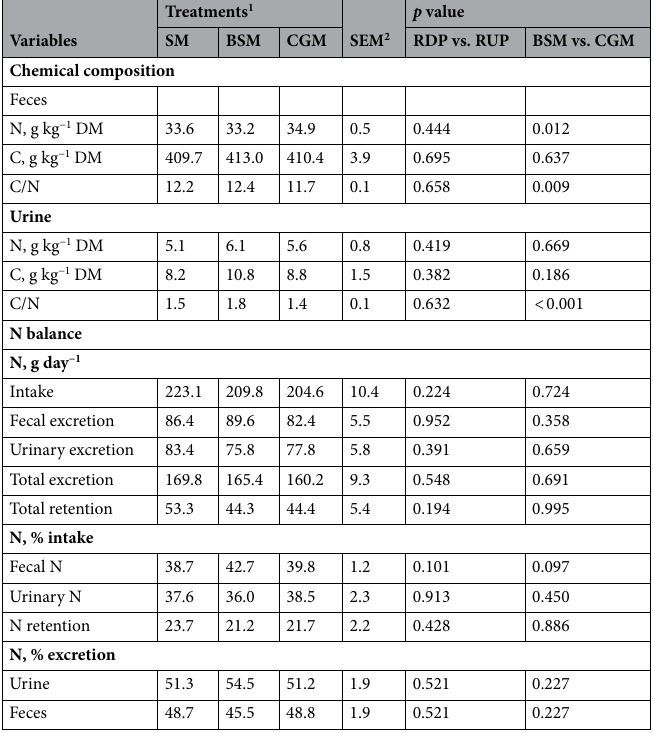
Table 1. Fecal and urinary N content and C and N balance of Nellore cattle fed with sources of rumen undegradable protein during the finishing phase in feedlots. 1 SM = manure of animals fed soybean meal as a source of rumen degradable protein (RDP), BSM = manure of animals fed by-pass soybean meal as a source of rumen undegradable protein (RUP), CGM = manure of animals fed corn gluten meal as a source of RUP; 2 SEM = standard error of the mean. Animal considered as an experimental unit (n =